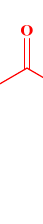
Figure 1. Ciprofloxacin structure with highlighted in red essential fragment for enzyme binding and highlighted in green possible modification positions.